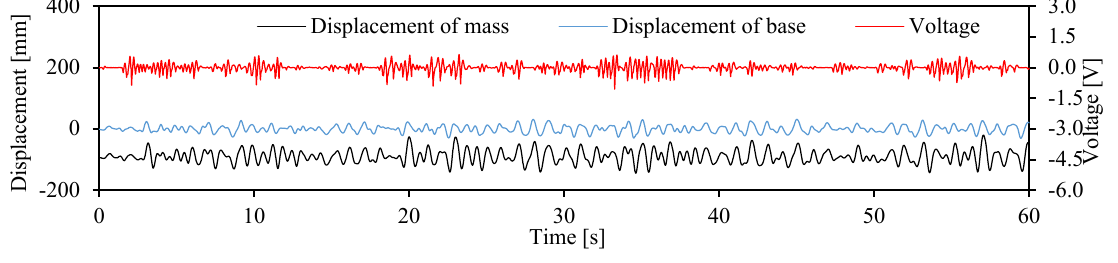
15 of 22 its maximum at approximately 1.9 Hz, whereas at 1.0 Hz, the amount of vibration power generated was zero as no relative displacement was indicated between the mass block and support point. Figure 17. Effect of periodic excitation signal frequency on vibration power generated. 3.3. Measurement Results Yielded by Random and Periodic Signal Co-Excitation The results yielded by the joint excitation of the random and periodic signals are shown in Figures 18–22. At the periodic signal of 1.0 Hz (see Figure 18), the vibration displacement of the mass block slightly exceeded that of the support point, which resulted in a single stable motion with standard deviations of 21.45 and 11.76 mm for the vibration displacements of the mass block and support point, respectively; consequently, 1.04 mW of power was output.